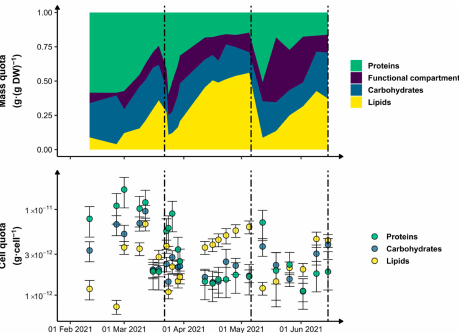
Figure 2. Storage molecule partition in Chlorella vulgaris NIES 227 biomass throughout the study. (It must be noted on the lower plot that the y-axis is represented in log